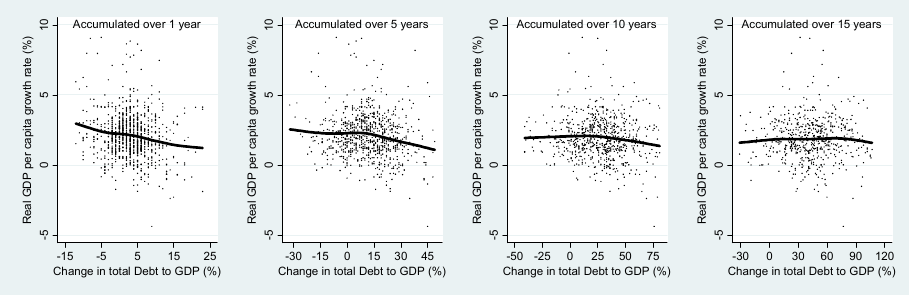
Figure 12 - Growth performance over 5 year with debt accumulation over 1-15 year (h=5 and d=1,5,10,15)